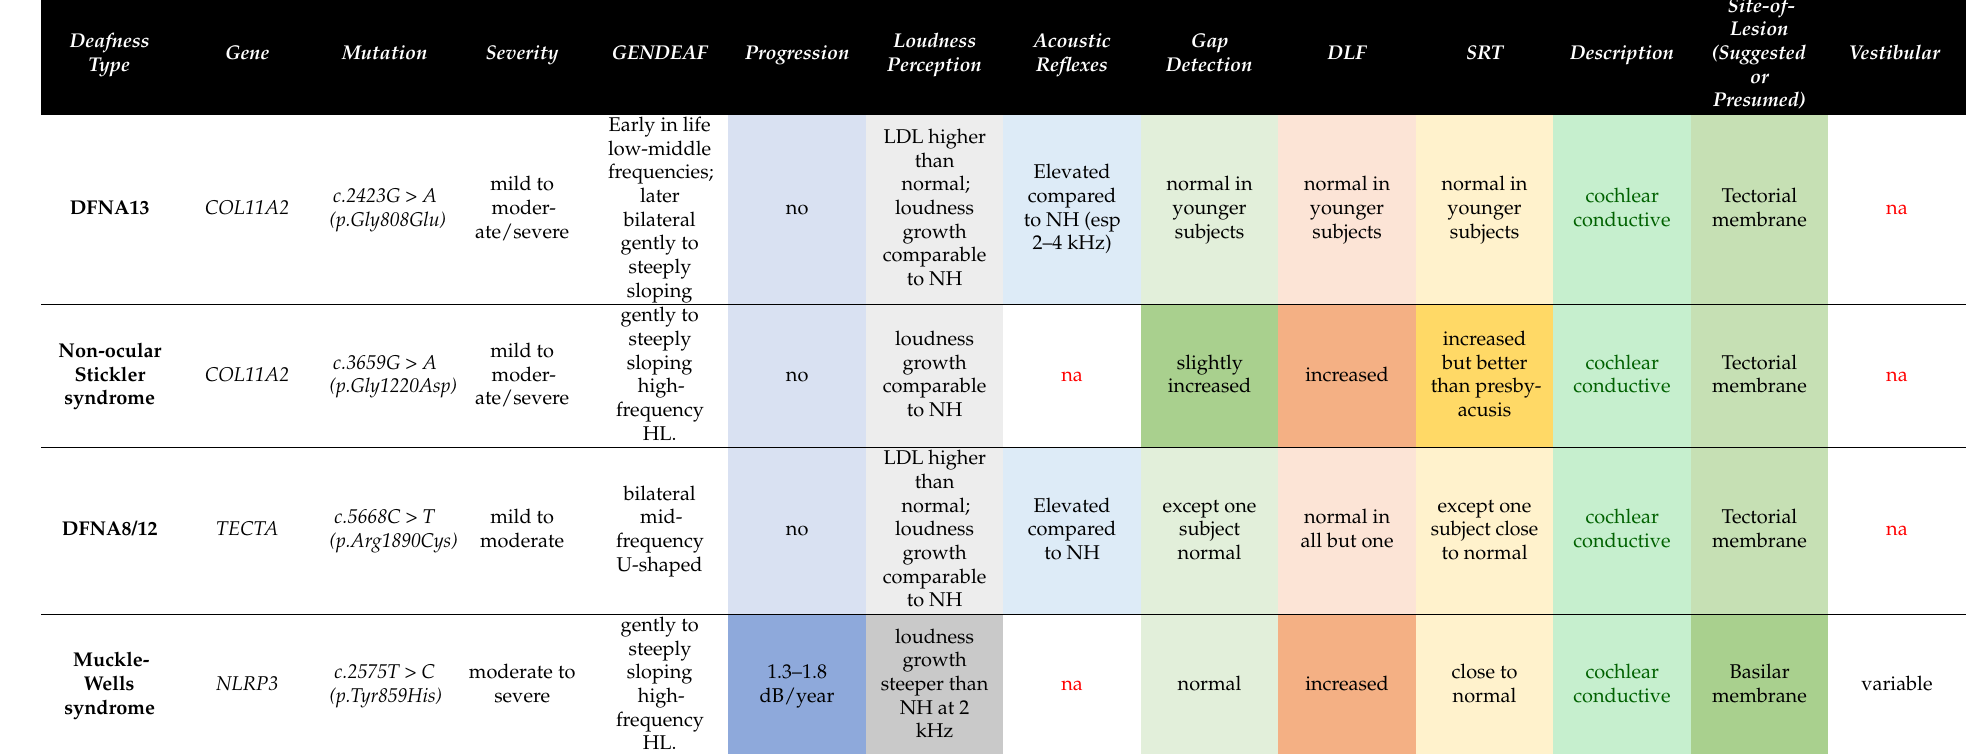
Table 1. Included and excluded patients with genetic hearing impairment taken from previous